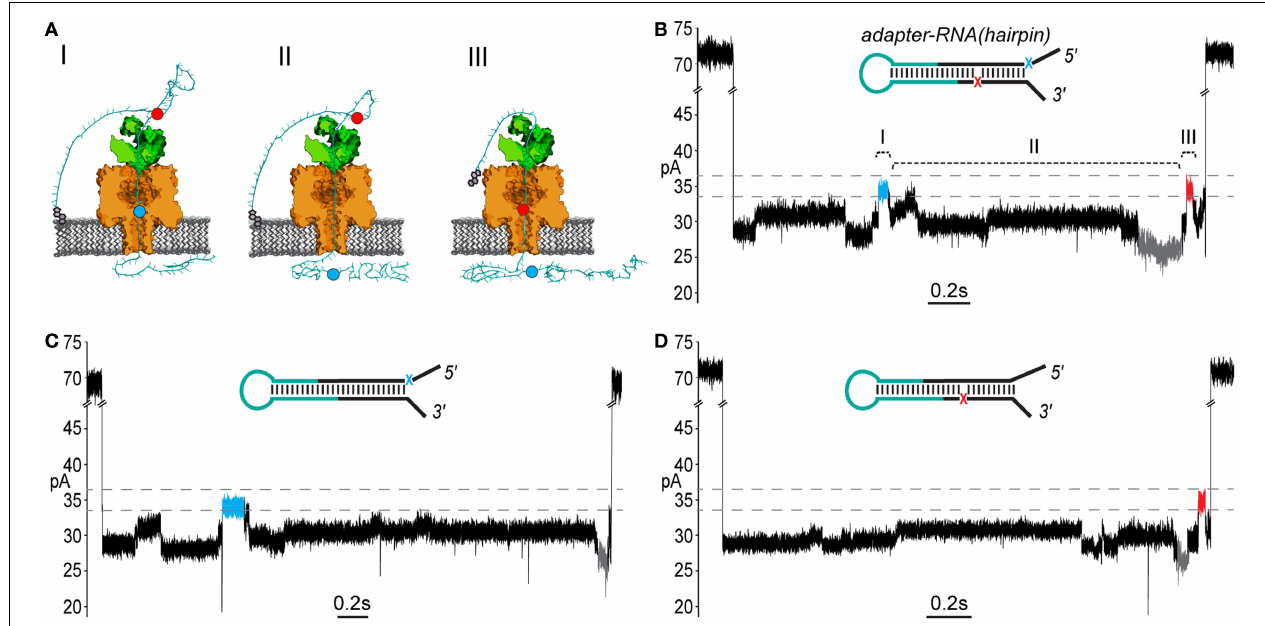
FIGURE 4 | End-to-end translocation of adapted RNA(hairpin) constructs through the α -HL nanopore . (A) A cartoon model showing capture and translocation of an adapted RNA(hairpin) complexed with ϕ 29 DNAP. The adapted RNA(hairpin) substrate is described in Figure 3 . (I) Following capture of the 5 ′ end of the adapter strand, the polynucleotide translocates through α -HL until the leading 5 ′ abasic residue (blue circle) reaches pore limiting aperture. (II) Translocation continues through the RNA portion of the adapted molecule. (III) The trailing 3 ′ abasic residue (red circle) reaches the pore limiting aperture after translocation of the RNA(hairpin). (B) A nanopore ionic current trace during translocation of an adapted RNA(hairpin) (inset), which corresponding to the cartoon